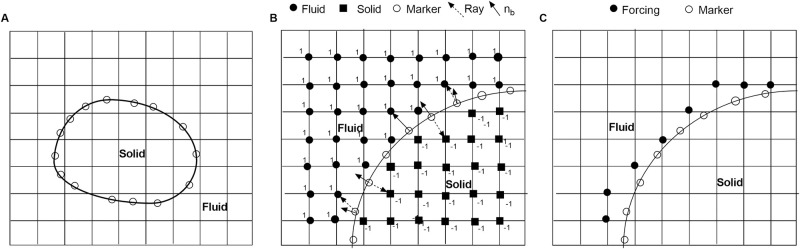
Tracking of solid-fluid interface used in the immersed boundary method.(A) An arbitrary shape solid in an orthogonal computational domain. Open circles indicate marker particles at the boundary which may not coincide with the Eulerian grid points. (B) Identification of solid and fluid points in the computational domain by a ray tracing algorithm. (C) Identification of forcing points (where forcing will be applied) near the boundary after tagging solid and fluid grid points in the computational domain.